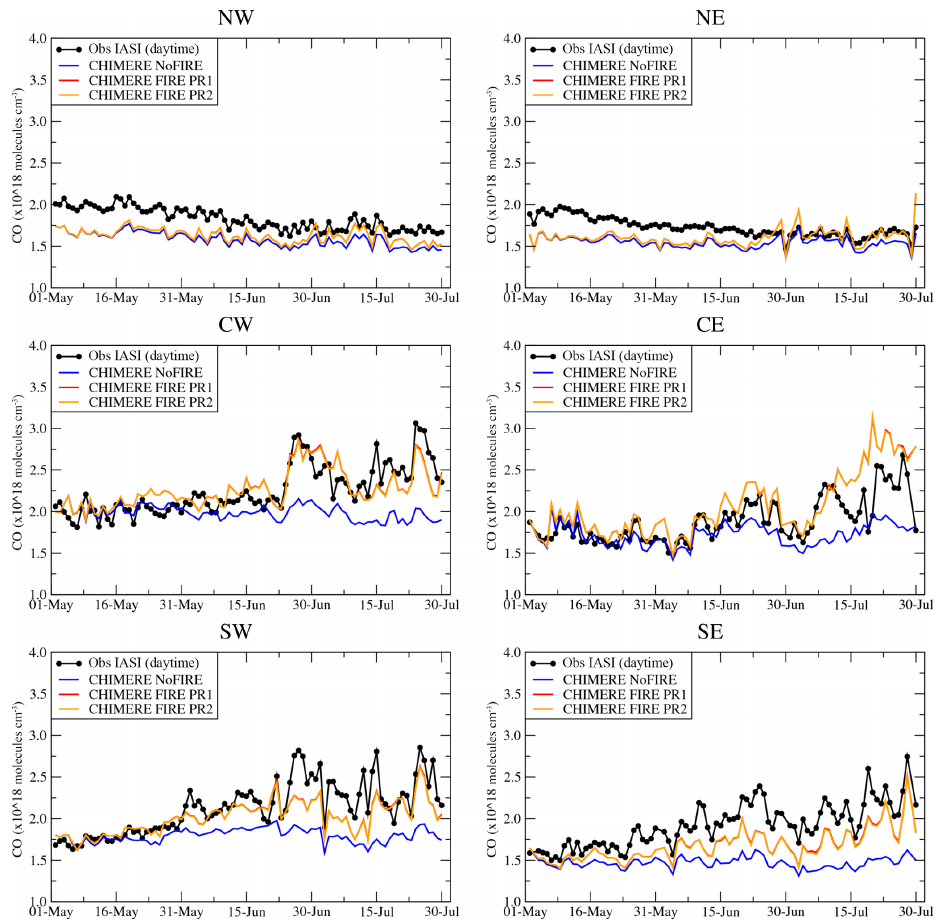
Figure 7. Time series of vertically integrated carbon monoxide (CO column) in 10 18 moleculescm − 2 for IASI and for the simulations with